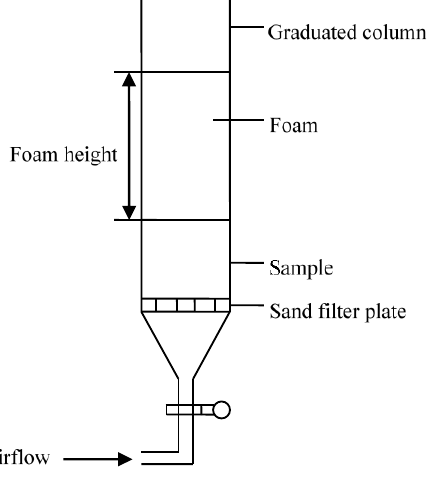
Figure 1. Diagrammatic sketch of the frothing property determined by the airflow method.